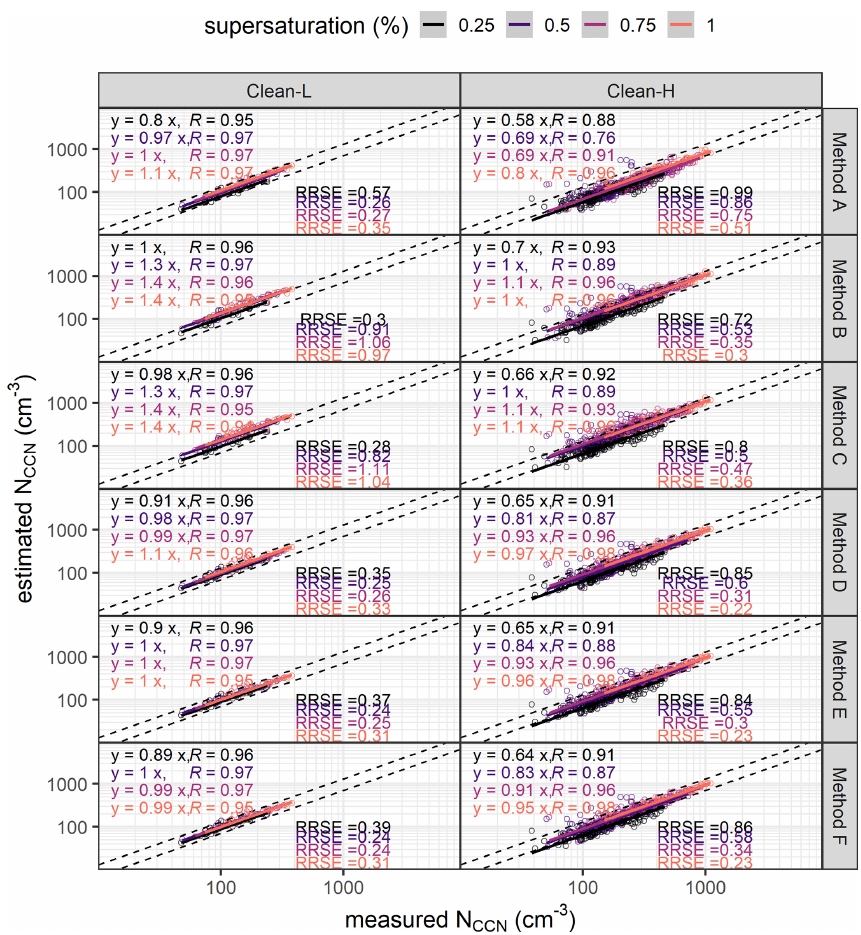
Figure 4. Comparison of measured N CCN against the estimated N CCN under different SS using each method in Clean- L and Clean- H periods. The colour codes representing SS, equation of regression line, Pearson correlation efficient and relative root square error (RRSE) are shown in each panel. The dashed lines represent ± 30% uncertainty ranges. Note that axes are in logarithmic